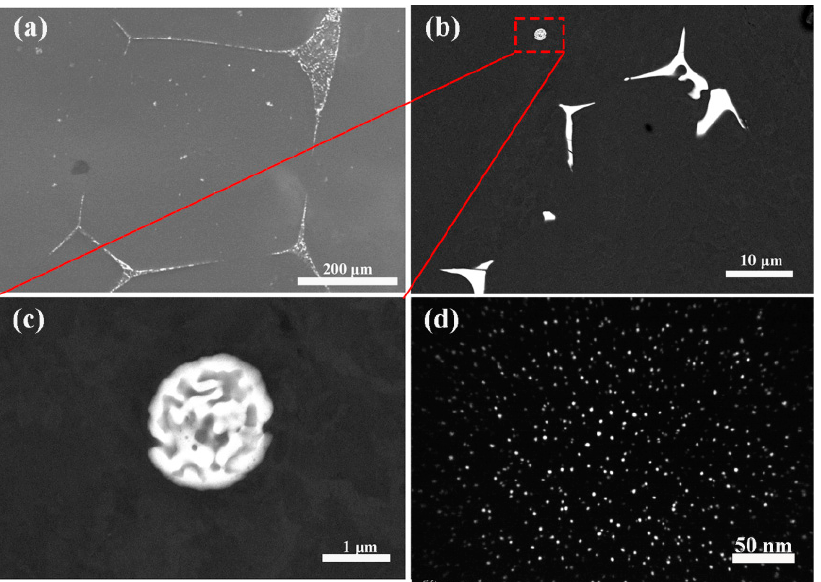
Figure 2. Micrographs of Al-Er-Hf alloy: ( a – c ) SEM micrographs of as-homogenized alloy; ( d ) dark- field TEM micrographs of precipitates of the peak aging alloy.